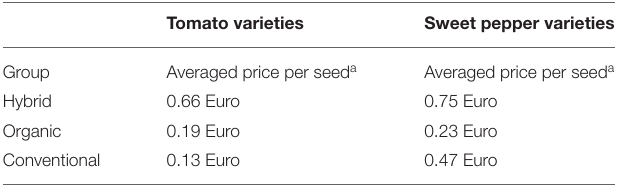
TABLE 1 | Averaged retail seed price for hybrid, organic, and conventional tomato and sweet pepper